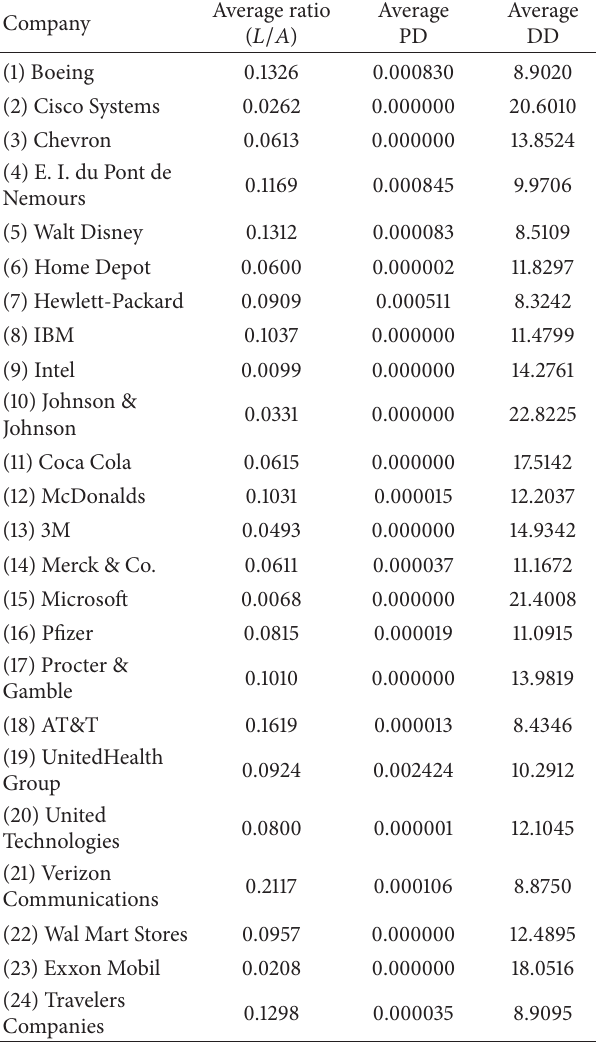
Table 2: Average values of ratio ( 𝐿/𝐴 ) and risk neutral PD and DD obtained from the KMV-Merton